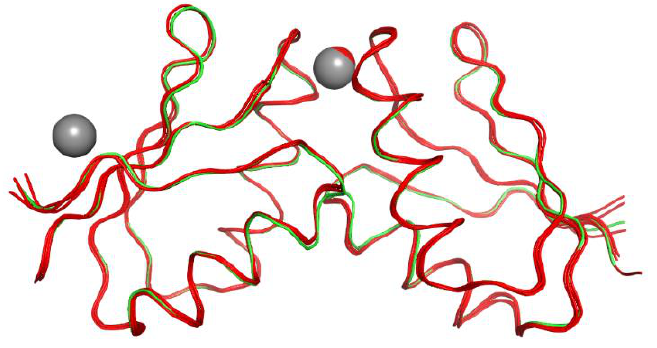
Figure 4. Superposition of the crystal structures containing Atox1 dimers. Protein molecules are in ribbon representation, while metal ions appear as spheres. Previously published 1FEE, 1FE0, 1FE4, and 4QOT are in red color, whilst the present crystal structure 7ZC3 is shown in green. Metal ions are Cu for 1FE0, Cd for 1FEO, Hg for 1FE4, Pt for 4QOT, and Zn for 7ZC3. The Zn ion presents a crystallographic occupancy of 0.69 and is surrounded by four cysteine residues (Cys12 and Cys15 of chains A and B). A partial crystallographic occupancy of the metal-binding site is reported also in other deposited Atox1 dimeric structures (PDB ID: 1FEE, 1FE0, 1FE4, and 4QOT), with values of 0.90 (Cu), 1.00 (Cd), 0.71 (Hg), and 0.35 (Cu) – 0.65 (Pt), respectively. The sulfur atoms of the cysteines around the cage are at 2.3 – 2.4 Å from the metal center and arranged in a tetrahedral geometry, with bond angles ranging from 105° to 118°, as expected for a regular tetrahedral coordination envi- ronment.